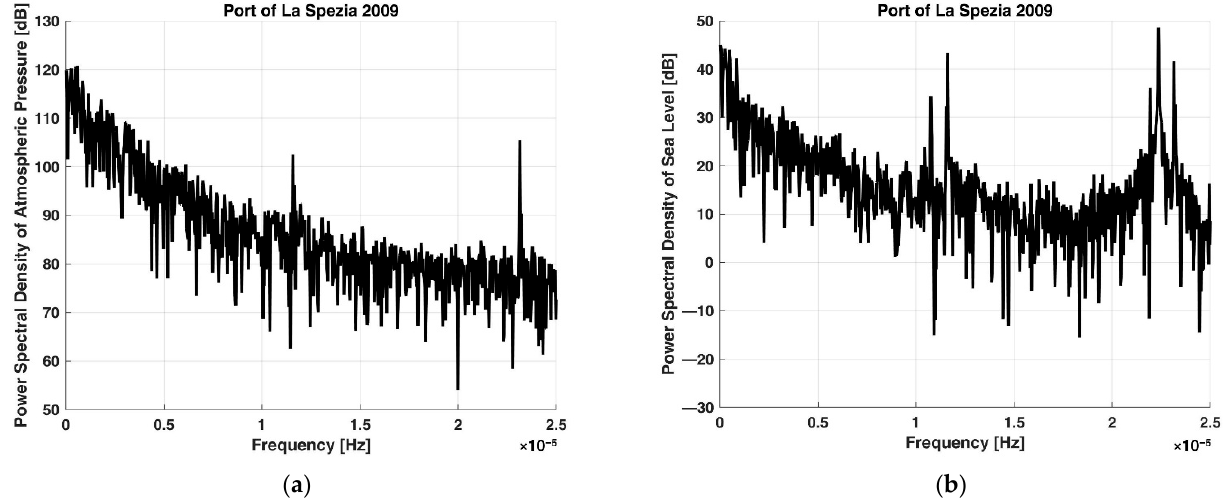
Figure 4. Power Spectral Densities of measurements carried out in 2009 within the port of La Spezia: ( a ) atmospheric pressure; ( b ) sea level.